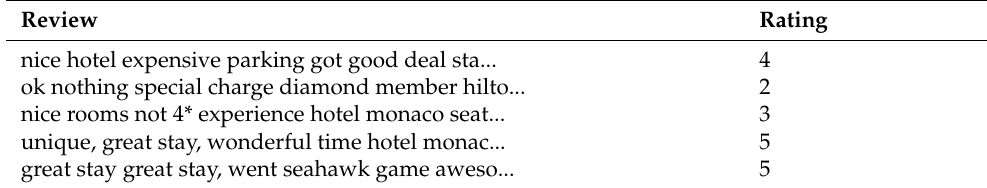
Table 1. Small example of the used dataset.